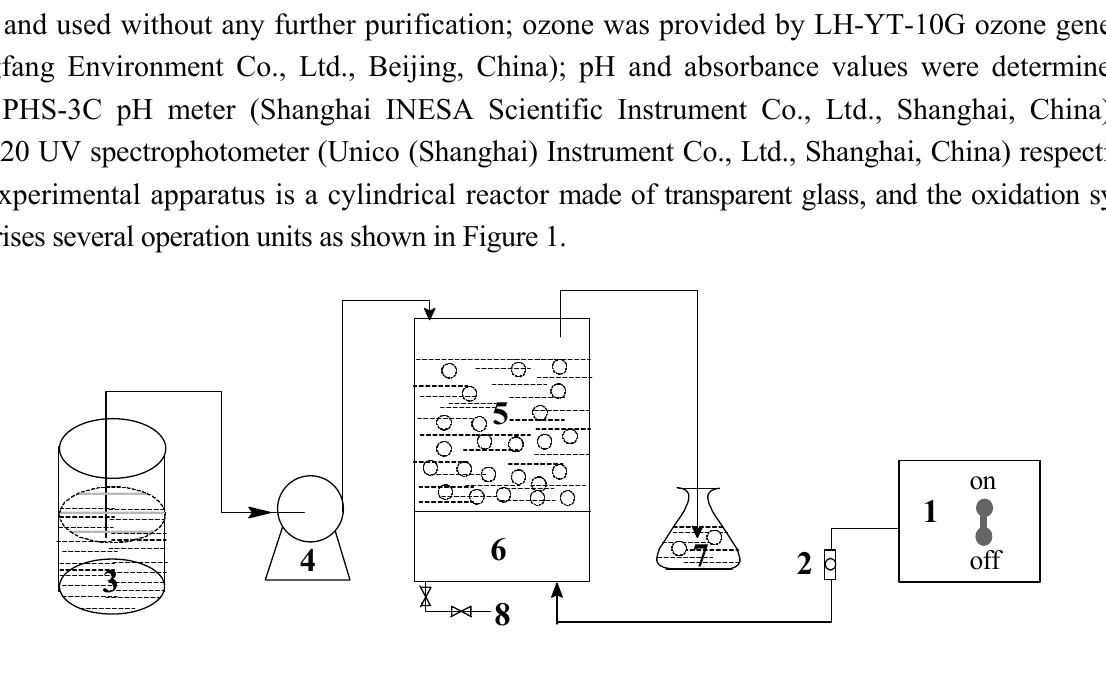
Figure 1. The flowchart of experimental apparatus. ( 1 ) Ozone generator; ( 2 ) Gas flowmeter; ( 3 ) Raw water tank; ( 4 ) Constant flow pump; ( 5 ) Reaction column; ( 6 ) Air distribution plate; ( 7 ) Tail gas absorption bottle; ( 8 )